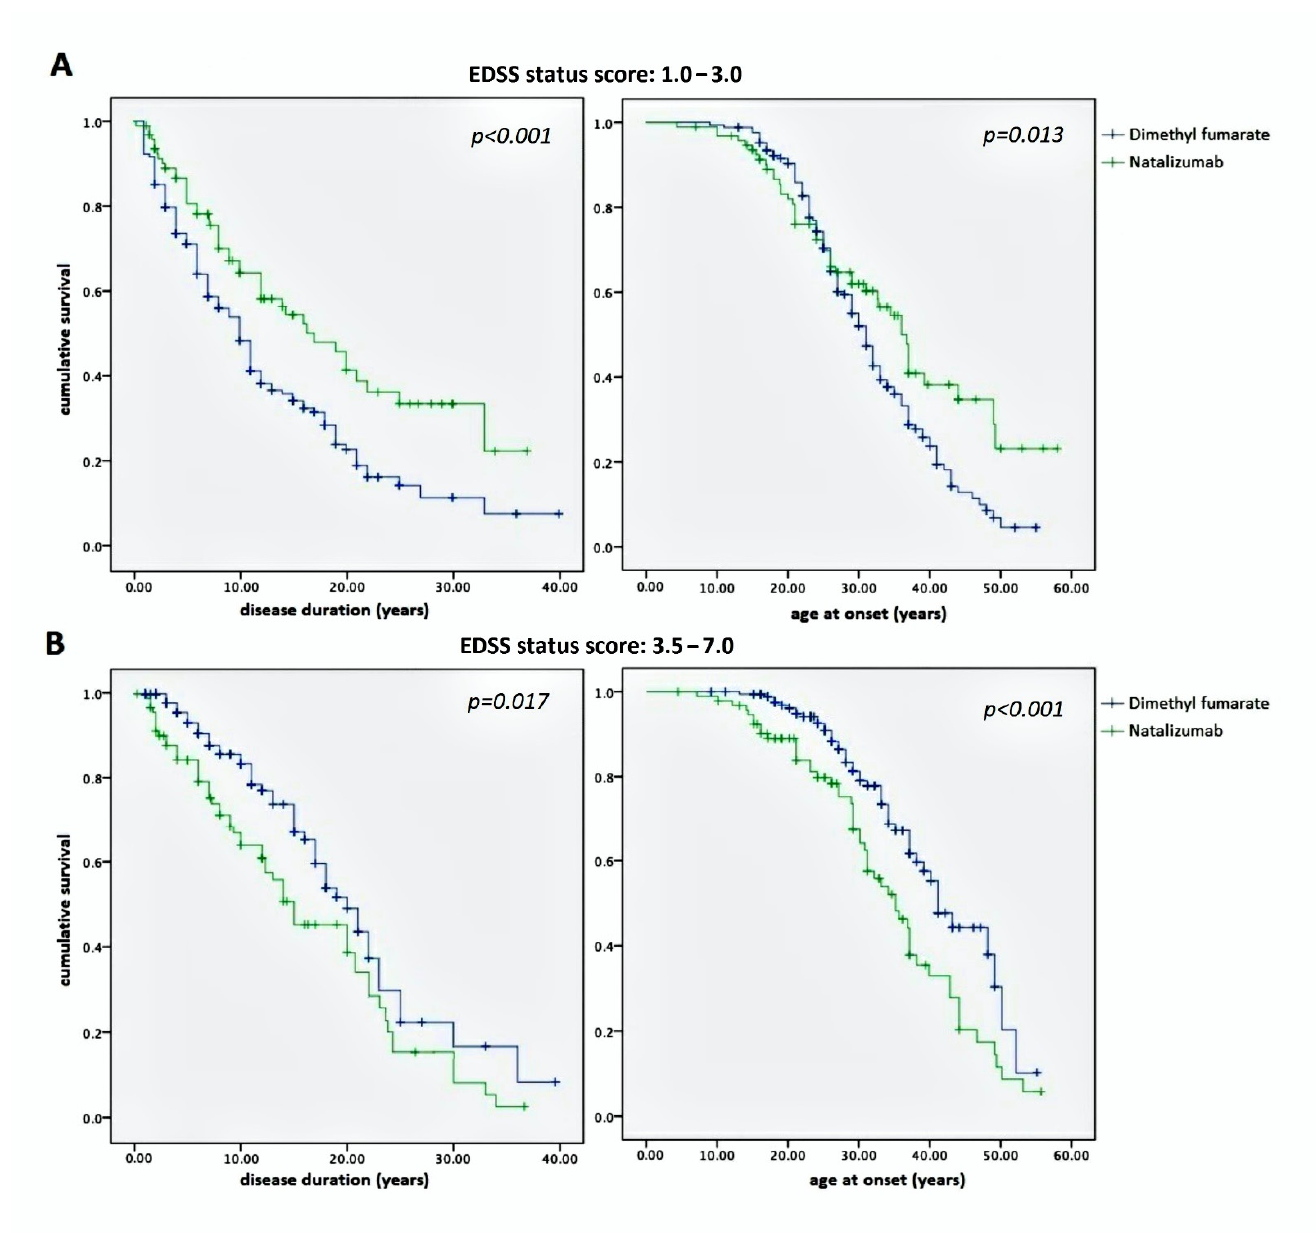
Figure 4. Kaplan–Meier curves representing the proportion of patients with EDSS status scores of 1.0–3.0 ( A ) and 3.5–7.0 ( B ) according to the disease duration (left) and age at onset (right), in both NTZ-treated and DMF-treated MS study populations. ( A ) Note the superiority of NTZ in preventing the disability progression and in maintaining an EDSS of 1.0–3.0 compared with DMF; conversely, ( B ) note the superiority of DMF in maintaining an EDSS of 3.5–7.0 compared with NTZ.